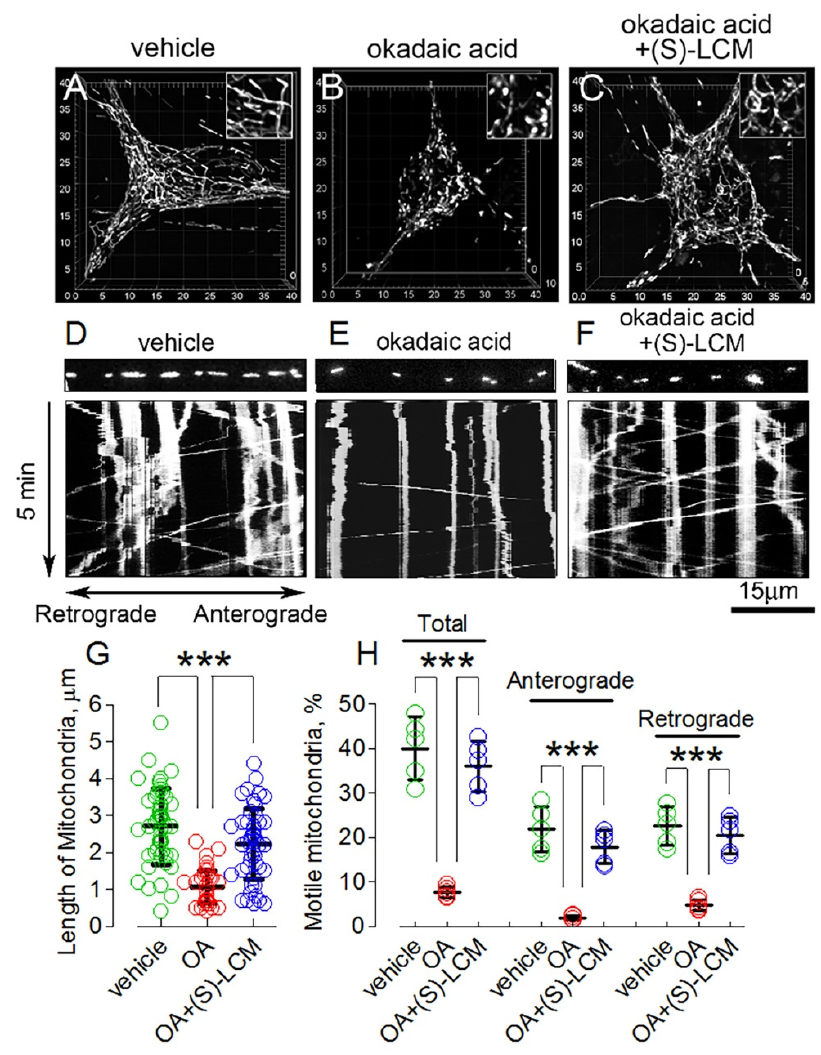
Figure 5. The okadaic acid (OA) induced an increase in mitochondrial fission and suppressed mitochondrial motility in cultured striatal neurons (10 DIV). (S)-lacosamide ((S)-LCM) rescued mitochondrial morphology and motility. Mitochondria were visualized by expressing mitochondrially targeted enhanced yellow fluorescent protein (mito-eYFP). Serial images (z-stacks) were collected as described in Materials and Methods. In ( A ), a 3-D image shows normal mitochondria in neuron treated with 0.01% DMSO, a vehicle. In ( B ), increased fission in neuron treated with 20 nM OA for 16 h. In ( C ), preservation of mitochondrial morphology in neuron treated with 30 µ M (S)-LCM and 20 nM OA for 16 h. In Insets, mitochondria are shown at additional 2x magnification. In ( D – E ), mitochondrial motility was recorded at 37 ◦ C for 5 min, and kymographs were constructed using NIH ImageJ 1.53a software. The angled traces indicate moving mitochondria, the straight vertical traces indicate stationary mitochondria. The strips show fluorescent images of mitochondria at the start of recordings. Where indicated, the OA (20 nM OA for 16 h) inhibited mitochondrial traffic in cultured striatal neurons ( E ). In ( F ), (S)-LCM (30 µ M (S)-LCM for 16 h) rescued mitochondrial motility. In ( D ), 0.01% DMSO was used as a vehicle. In ( G ), the length of mitochondria is in µ m. In total, 100 randomly chosen mitochondria from at least 10 neurons from three different platings were analyzed. Data are mean ± SD. In ( H ), the percentages of total motile mitochondria and mitochondria moving in anterograde and retrograde directions are shown. Data are mean ± SD. In ( G , H ), *** p < 0.001 comparing OA with vehicle and OA plus (S)-LCM, n = 5 separate, independent experiments. The colored circles indicate data from individual